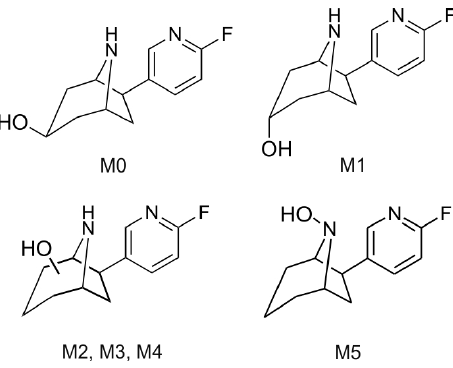
Figure 8. Identified monohydroxylated metabolites of (+)- 1 after incubation with liver microsomes.